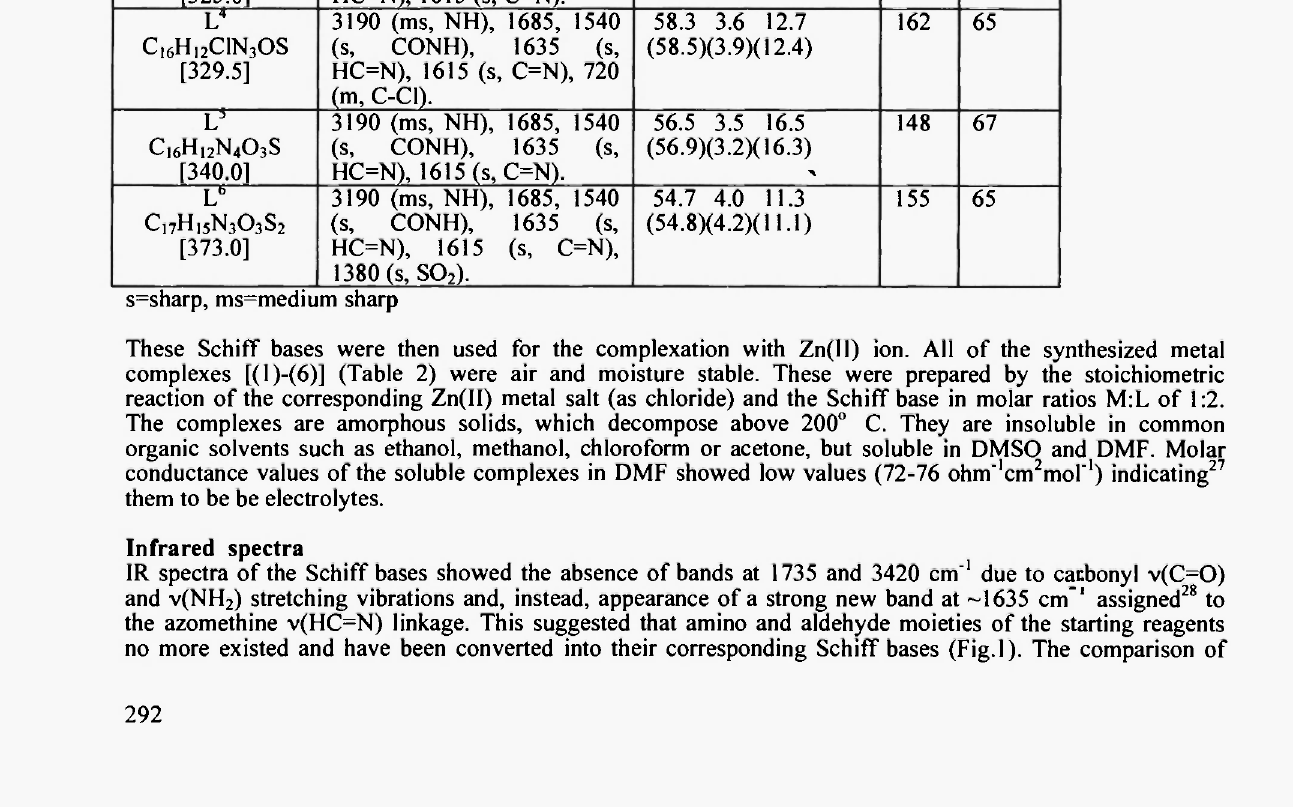
Table I. Physical, Spectral and Analytical Data of the Schiff bases. Schiff